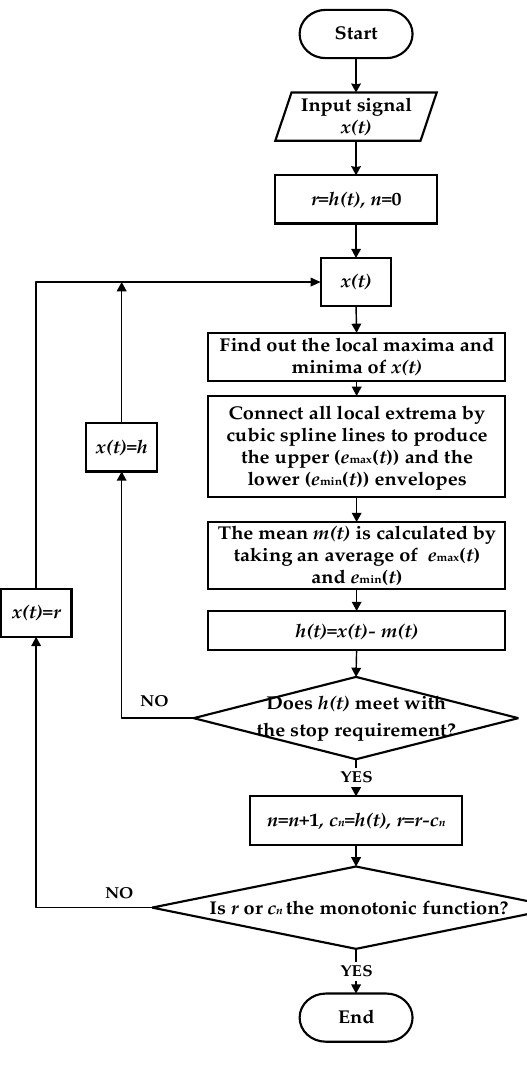
Figure 9. Flowchart for EMD method.